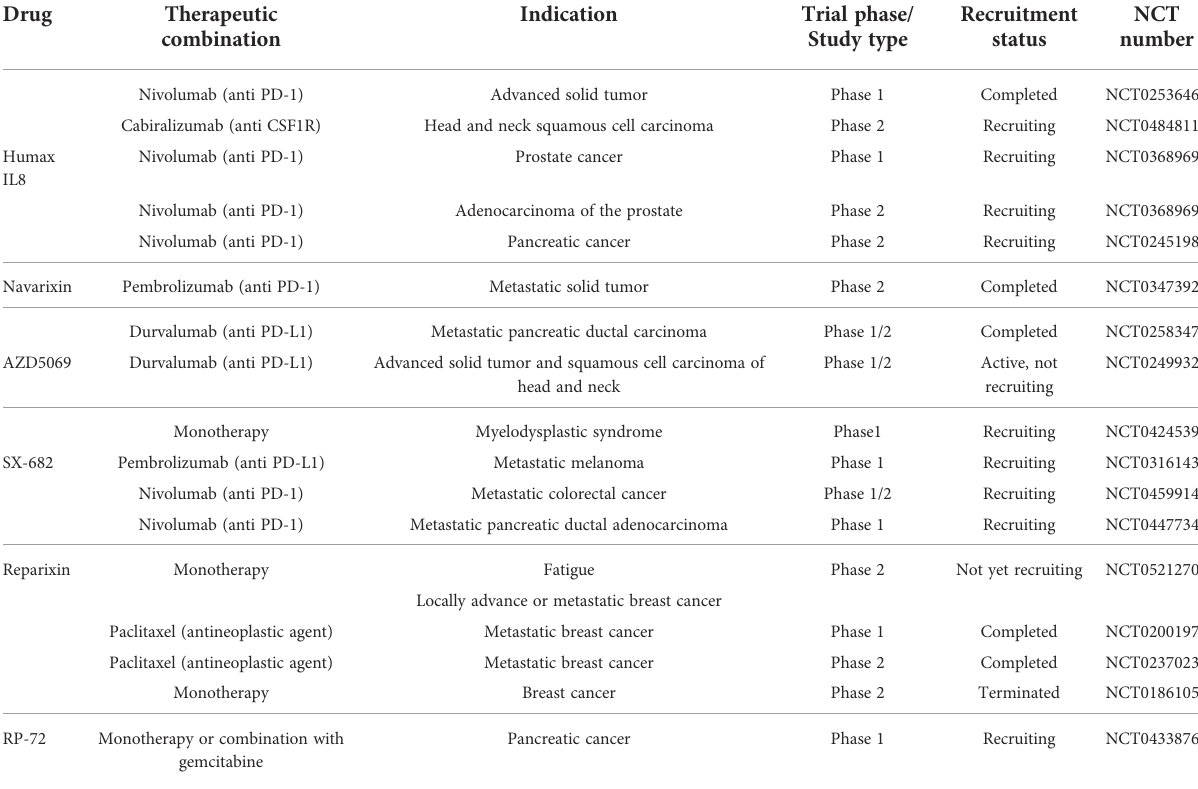
TABLE 1 Summary of the main CXCL8-CXCR1/2 inhibitors for cancer therapy.